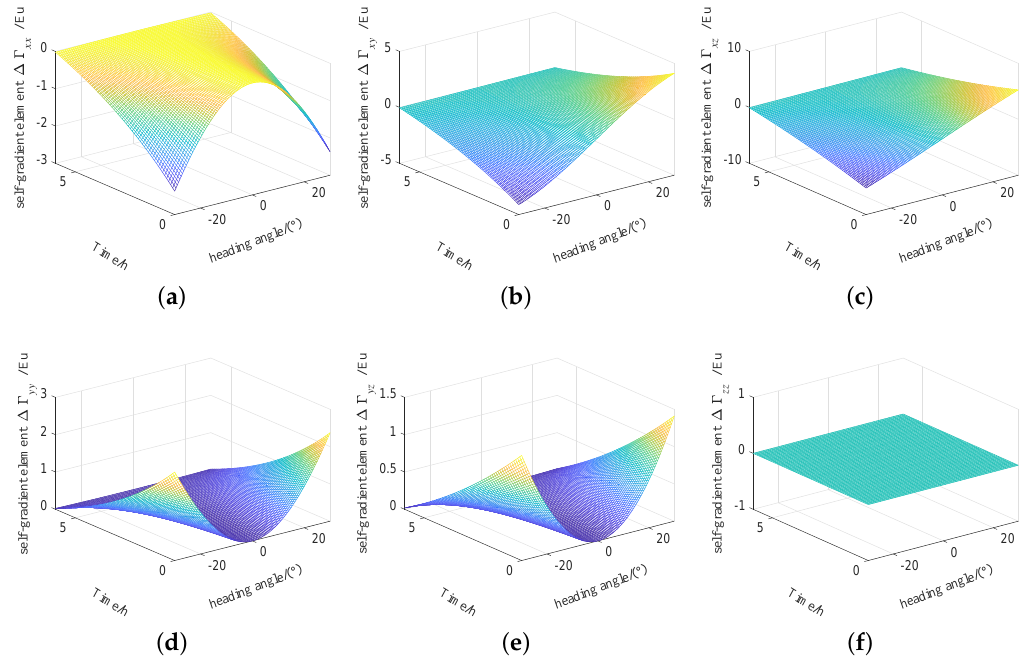
Figure 7. Self-gradient caused by the fuel mass of the carrier in heading attitude. ( a ) Self-gradient element Γ xx . ( b ) Self-gradient element Γ xy . ( c ) Self-gradient element Γ xz . ( d ) Self-gradient element Γ yy . ( e ) Self-gradient element Γ yz . ( f ) Self-gradient element Γ zz .